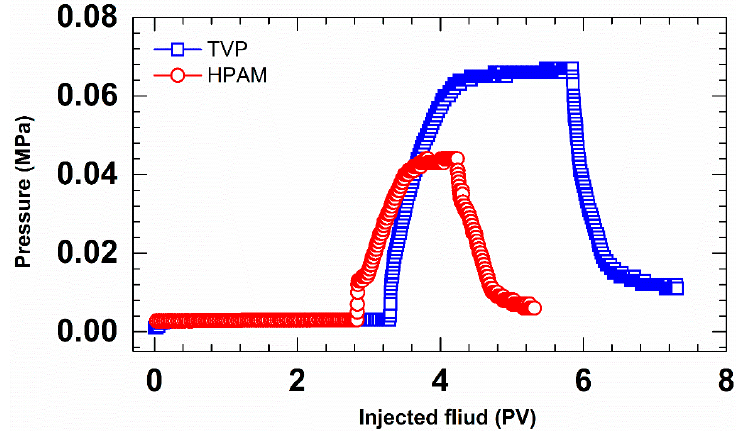
Figure 6. Variation in pressure versus pore volume (PV) during the propagation of 0.1% TVP or HPAM solution in natural cores at 45 ° C with the injection rate of 2 mL/min. The 0.5% mother polymer solutions were prepared with 4500 mg/L synthetic produced fluid containing 65 mg/L Ca 2+ and Mg 2+ , and then diluted to 0.1% polymer solution with the synthetic brine with TDS of 950 mg/L NaCl. Table 1. The resistance factor ( F r ) and residual resistance factor ( F rr ) of 0.1% TVP and HPAM solutions flowing in natural Daqing cores at 45 ◦ C.